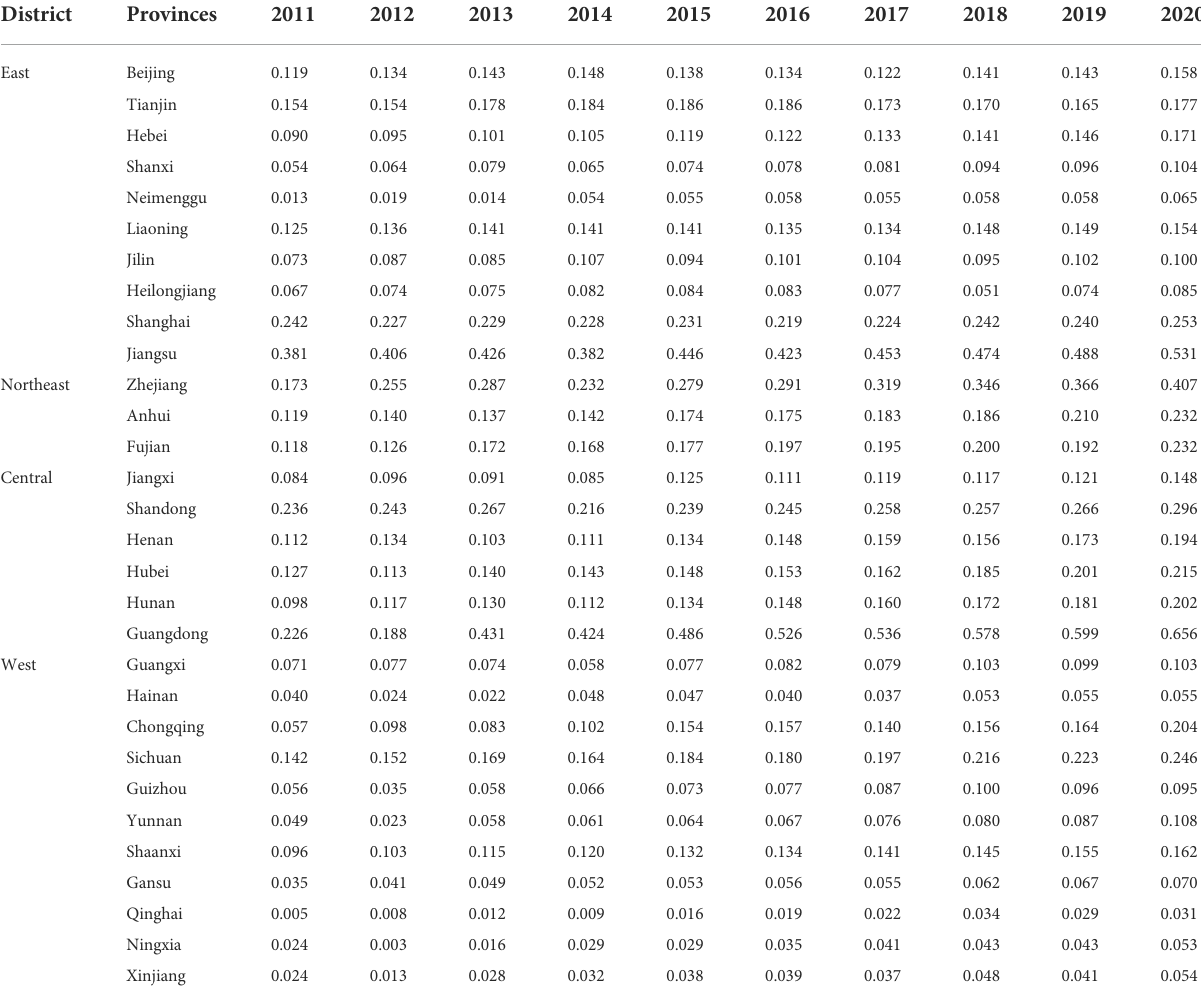
TABLE 2 Coupling coordinated development